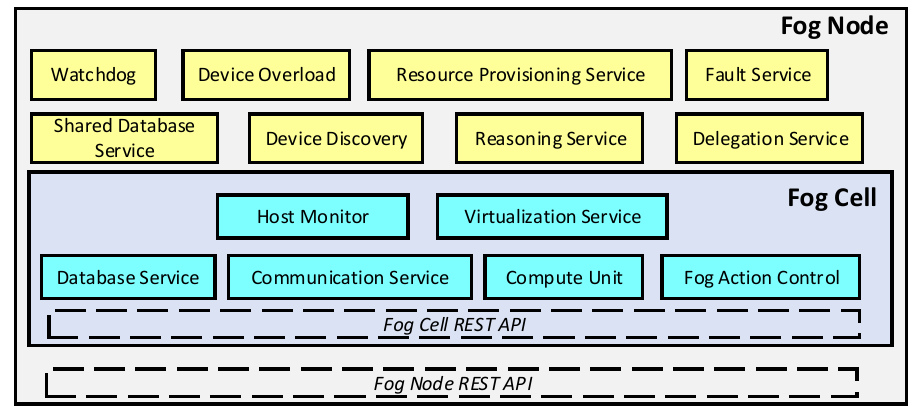
Figure 8. VMCS Fog Cells and Nodes